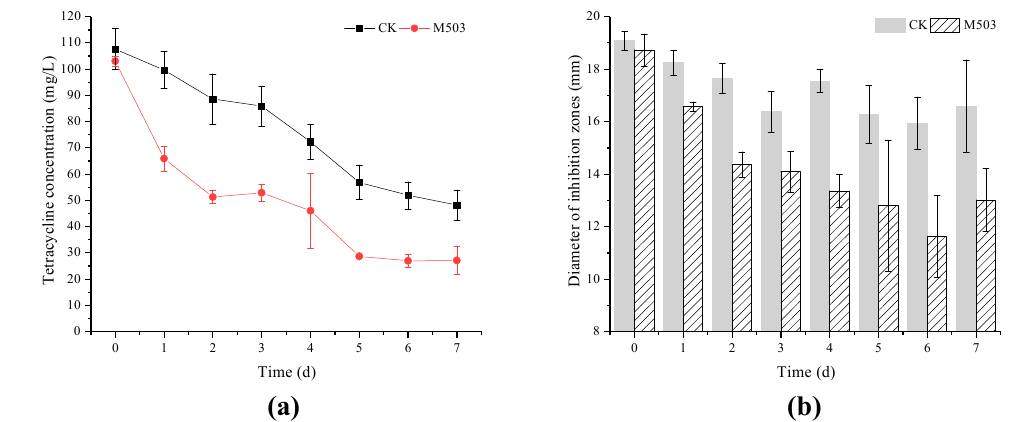
Figure 6. Doxycycline degradation curves and antibacterial potency of degradation products of two groups at seven days (bar plot) ( a ). Chlorotetracycline degradation curves and antibacterial potency of degradation products of two groups at two days (bar plot) ( b ). (M503: group with strain M503; CK: group without srain M503.) Values are expressed as mean of three replicates with standard deviations. In the experiments of CTC degradation, the strain M503 could degrade 100 mg/L CTC completely within two days. The differences in the inhibition zones between the experi- mental and control groups indicated that the biodegradability of strain M503 could alle- viate the antibacterial potency of TC, DC, and CTC. 4. Discussion